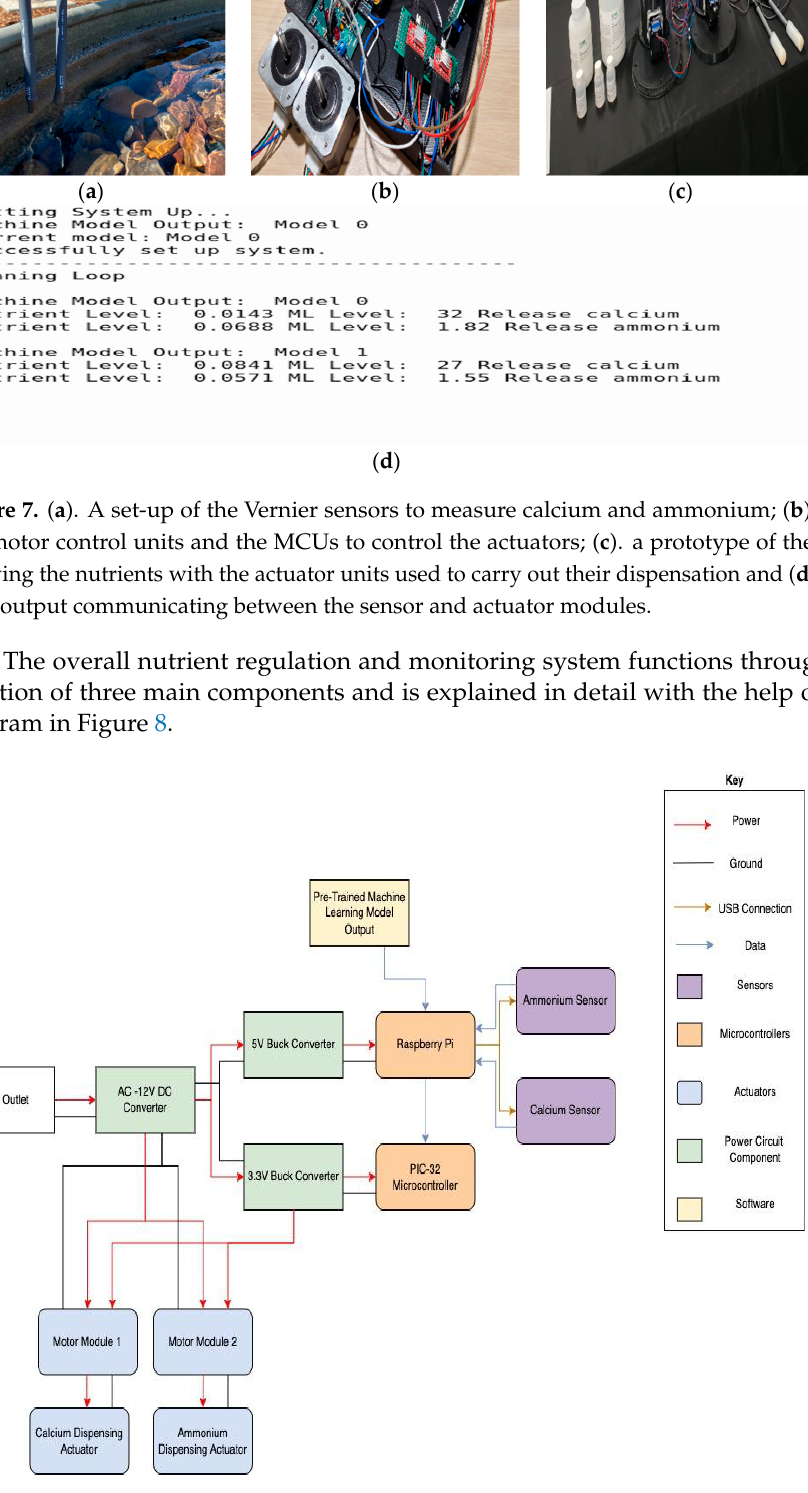
Figure 8. Detailed block diagram of the IoT-based sensing and dispensing system.